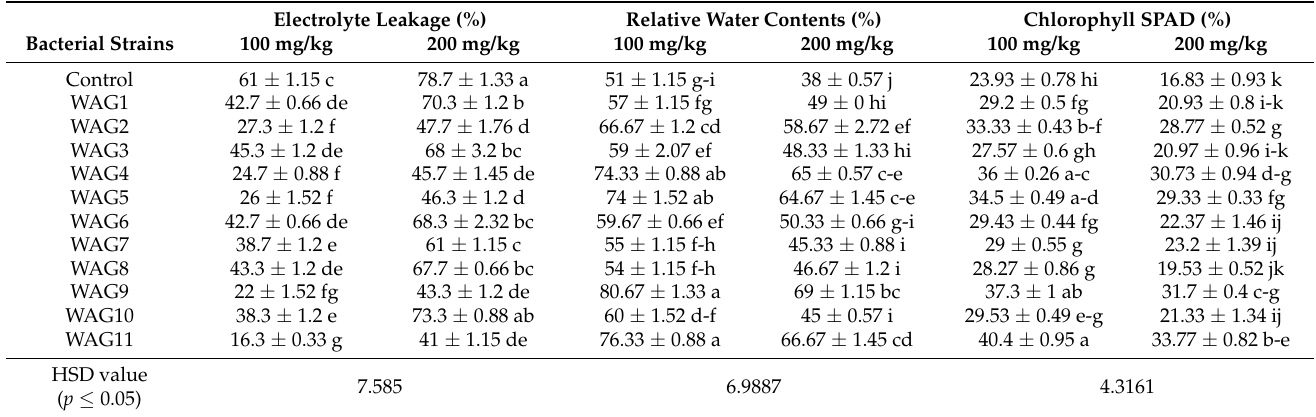
Table 4. Effect of isolated bacterial strains on physiological characteristics of maize plants in glyphosate-spiked sand.